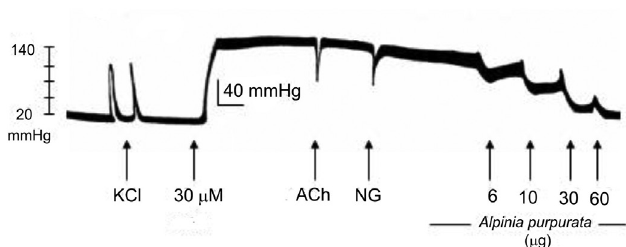
FIGURE 1 - Representative perfusion pressure (mmHg) trace showing the vasodilator effect of Alpinia purpurata hydroalcoholic extracts on MVB pre-contracted with NE (30 m M) added to the perfusion fluid. Acetylcoline (Ach, 10 pmol) and Nitroglycerin (NG, 10 nmol) were also injected to test the endothelium-dependent and independent responses before dose-responses curves to extracts were obtained.